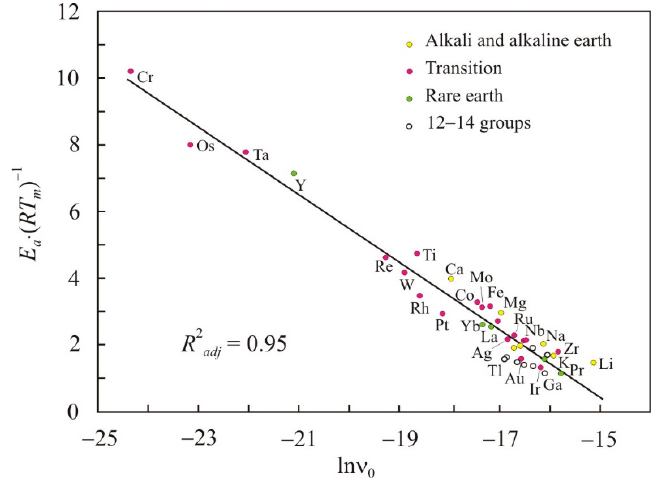
Figure 1. Relation of the reduced activation energy E a ·( RT m ) − 1 with the pre-exponential factor in the natural logarithmic scale ln ν 0 for liquid metals at the melting point T m .